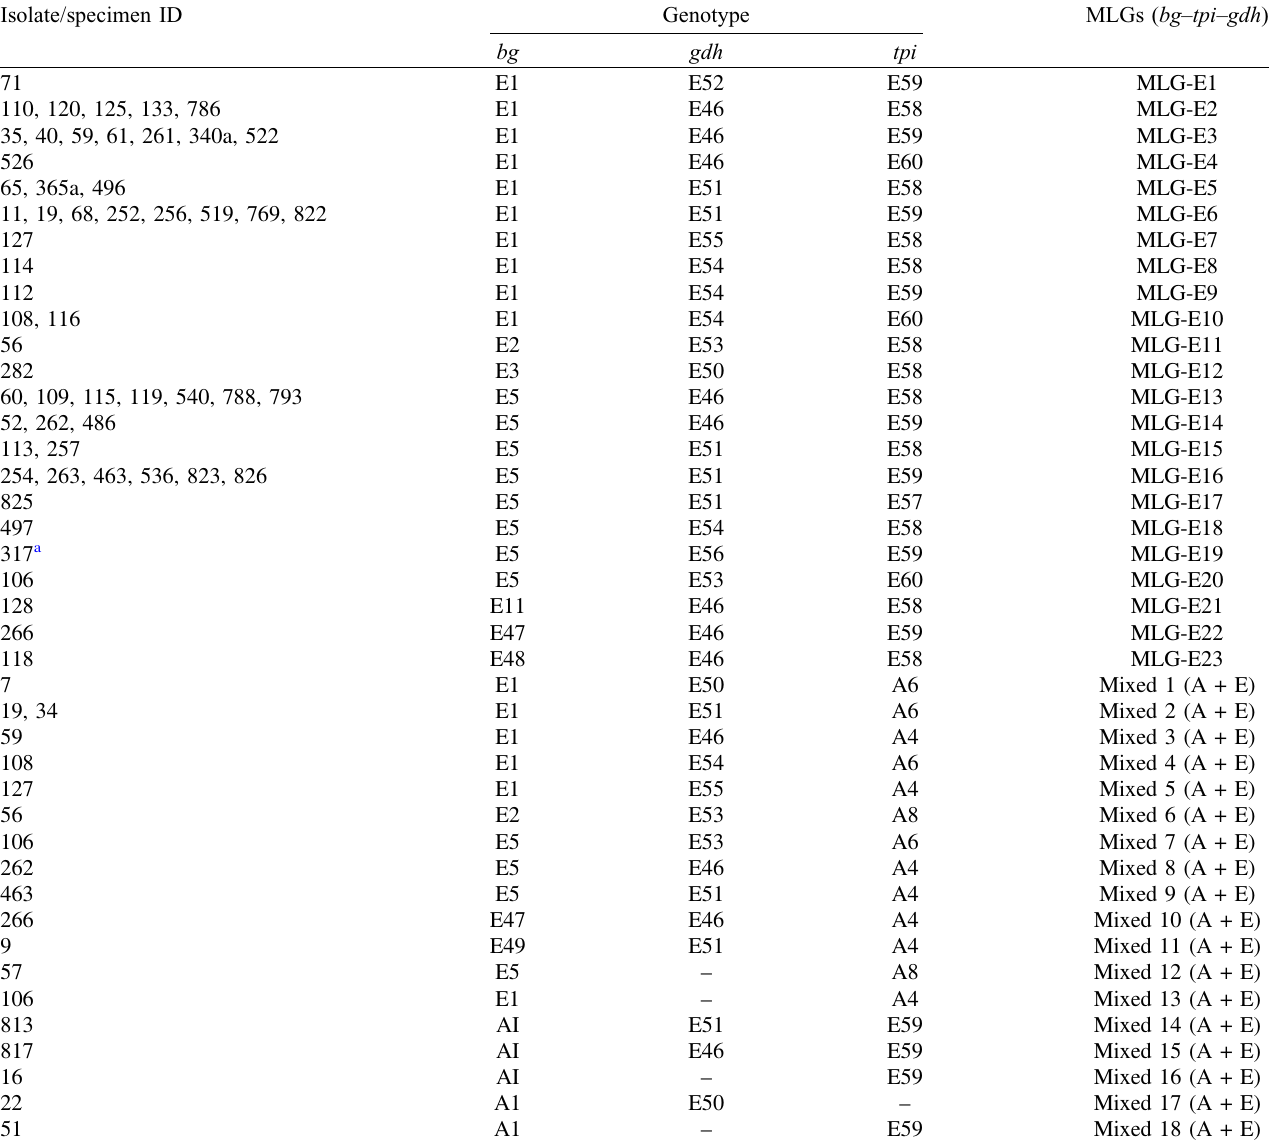
Table 5. Multilocus sequence genotyping of G. duodenalis in Hu sheep in Henan Province using the bg , tpi, and gdh genes. Isolate/specimen